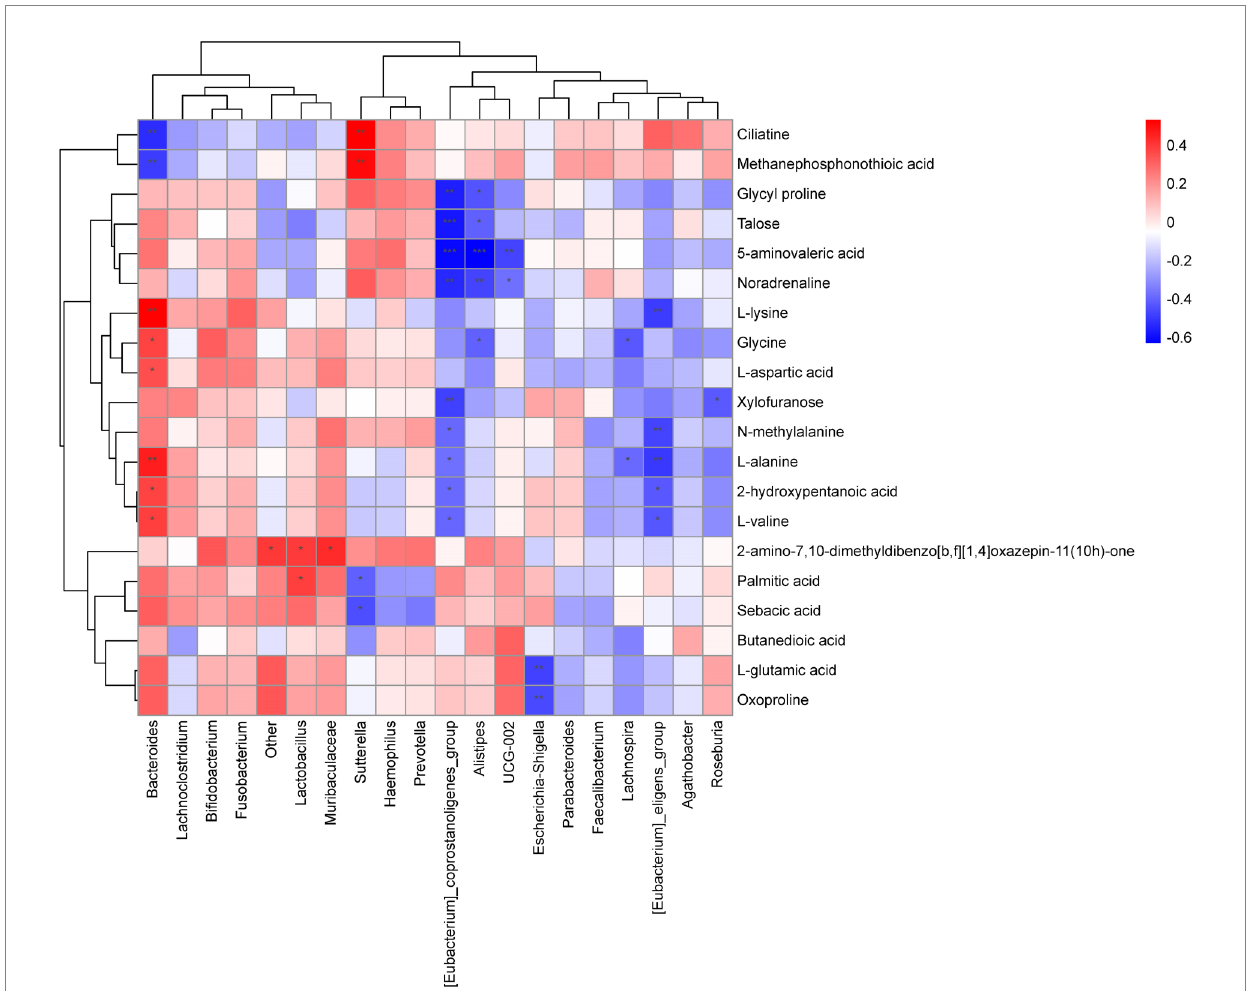
FIGURE 7 Heat map of correlation between microbiome and metabolites. Each column is for a different species and each row corresponds to a metabolite. The graph shows positive correlations in orange and negative correlations in blue, with darker colours representing greater correlations and colours closer to white representing correlations closer to zero. A *** in the graph represents a correlation p value less than 0.001, a ** in the graph represents a correlation p value less than 0.01 and a * in the graph represents a correlation p value less than